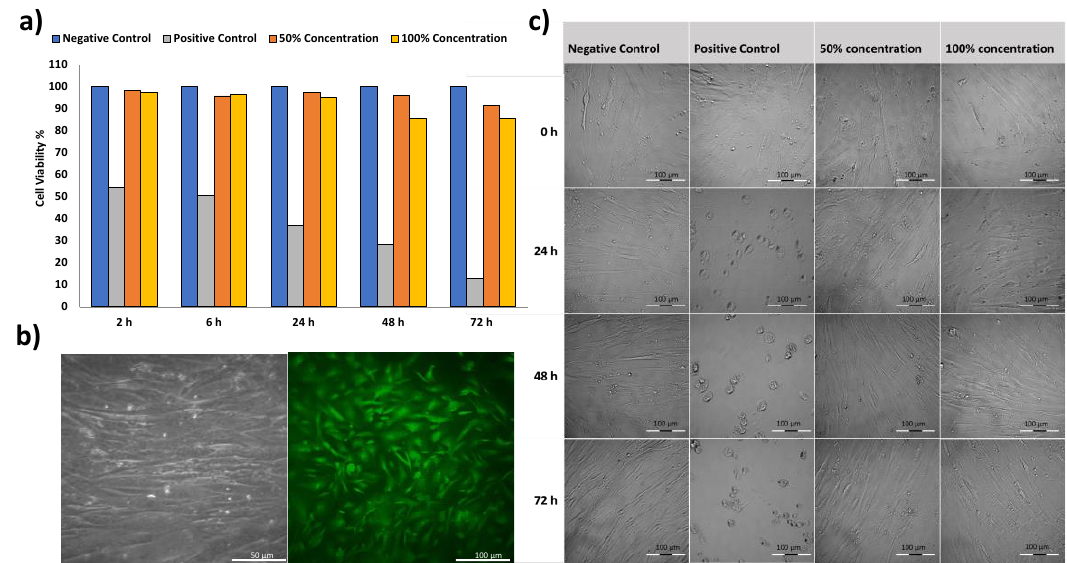
Figure 7. ( a ) Cell viability results at increasing extraction solution concentrations and increasing time. All tests were repeated in four independent incubations for each experiment, and each experiment was repeated three times. ( b ) Light (left) and confocal (right) microscope images of HSF cells on the hydrogel surface at day 3 and ( c ) white light images of cells before the urazole treatment, and on each day after the urazole treatment.